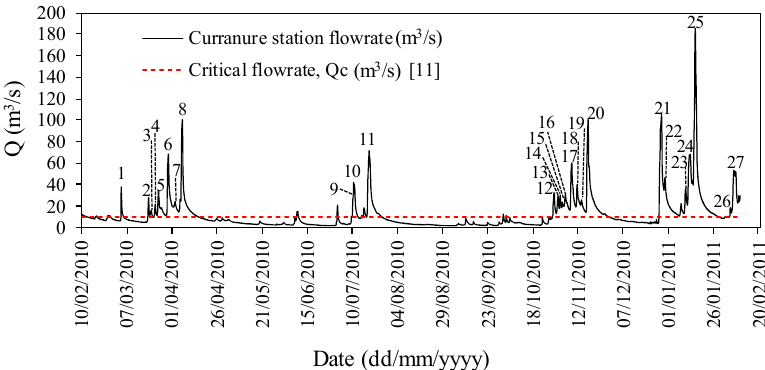
Figure 3. Flow rates of the 27 storm-based events modeled to calculate the suspended sediment concentration ( SSC ) .